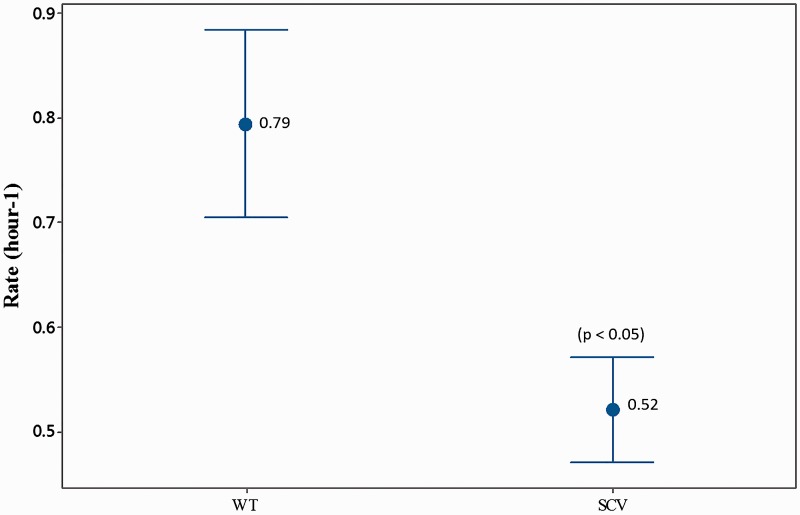
Mean growth rate of biofilm-derived SCV phenotype. The growth rate was assessed for SCVs from the exponential growth phase (between 4 and 8 h of growth) from triplicate growth experiments. SCV rate was calculated using pooled data from all 12 sequenced SCVs. A two-sample t-test was used to compare SCV rate to the WT rate. Numbers signify mean values. Error bars represent 95% confidence intervals.